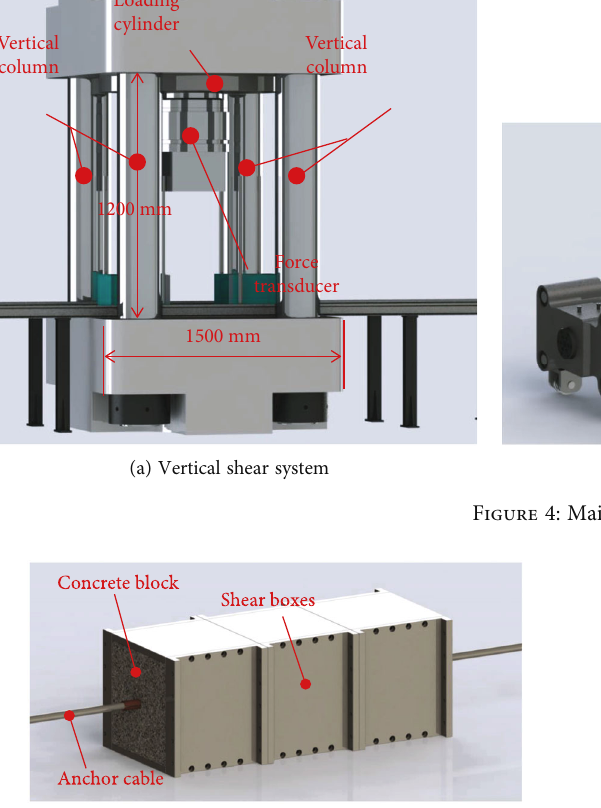
Figure 5: Shear box.